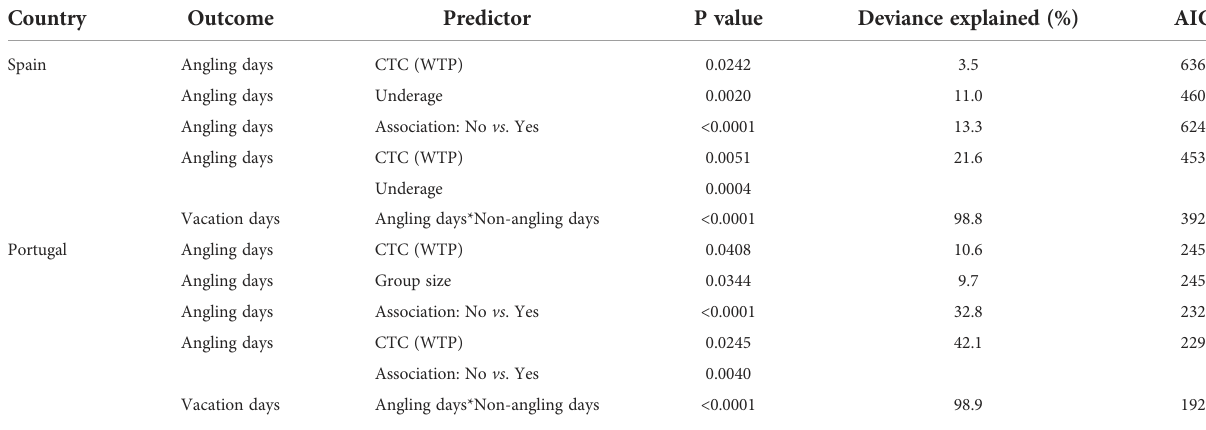
TABLE 4 Outputs of the GAMs fi tted on the number of angling days and number of vacation days (including non-angling days, devoted to alternative recreational activities).